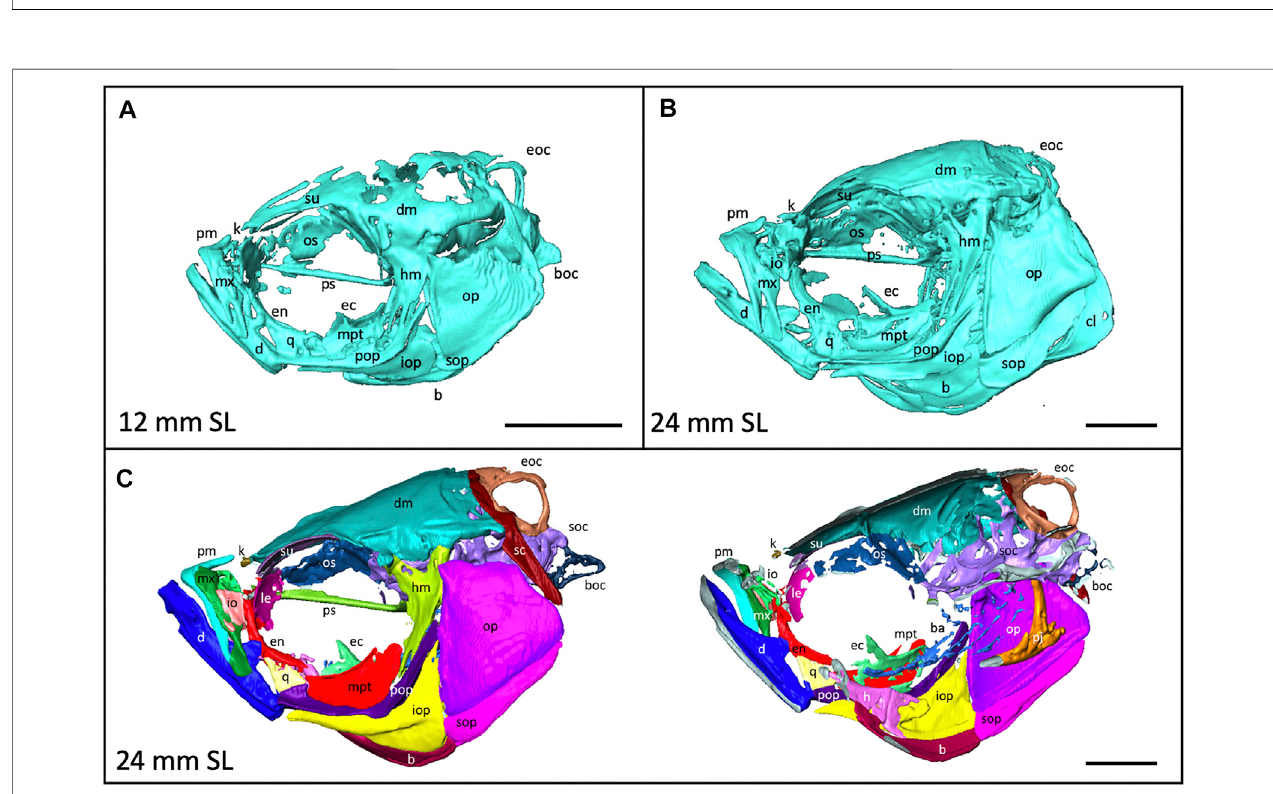
FIGURE4| Anatomyofthecraniofacialskeleton. (A) ,Volumerenderingoftheskullofa12 mmSLzebra fi shand (B) ,a24 mmSLzebra fi sh. (C) ,Lateralviewofskull of 24 mm SL zebra fi sh with segmented bones (left). Cross section of lateral view reveals some internal elements (right). b, basibrachials; ba, branchial arches; boc, basioccipital; d, dentary; dm, dermatocranium; ec, ectopterygoid; eoc, exocciptal; en, entopterygoid; h, hyoid; hm, hyomandibula; io, infraorbital; iop, interopercle; k, kinethmoid; le, lateral ethmoid; m, maxilla; mpt, metapterygoid; op, opercle; os, orbitosphenoid; pj, pharyngeal jaws; pm, premaxilla; pop, preopercle; ps, parasphenoid, q, quadrate; sc, supracleithrum; soc, supraoccipital; sop, subopercle, su, supraorbital. Scale bars, 1 mm.